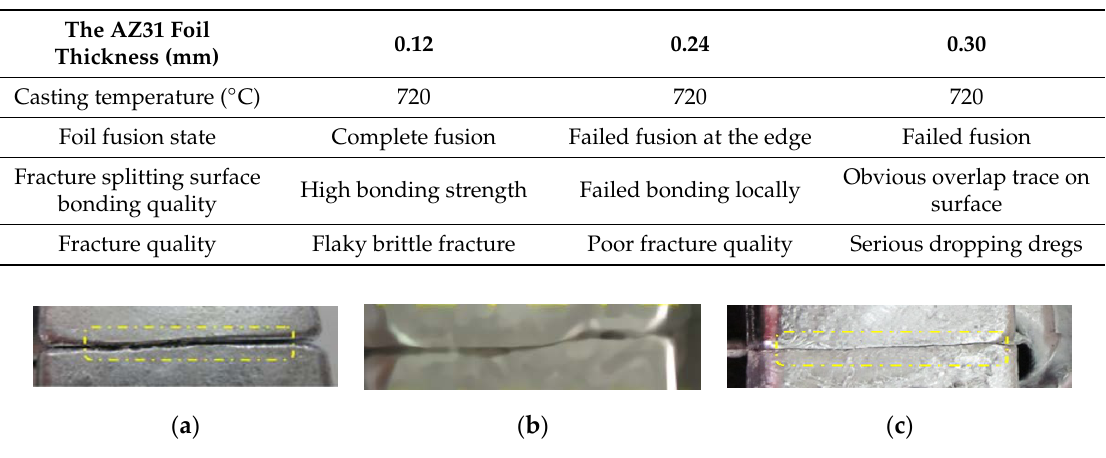
Figure 3. Casting bonding surfaces with AZ31 foil of different thicknesses ( a ) 0.3 mm AZ31 foil, ( b ) 0.24 mm AZ31 foil, ( c ) 0.12 mm AZ31 foil. Table 3. Fracture splitting surface quality with AZ31 foils of different thicknesses.